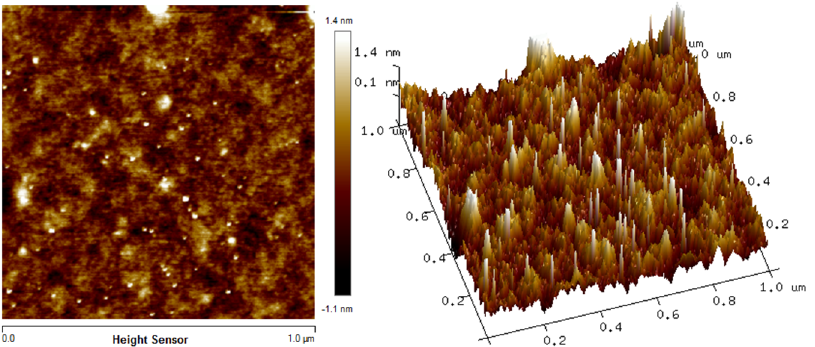
Figure 3. Atomic force microscopy (AFM) image of chitosan thin film.